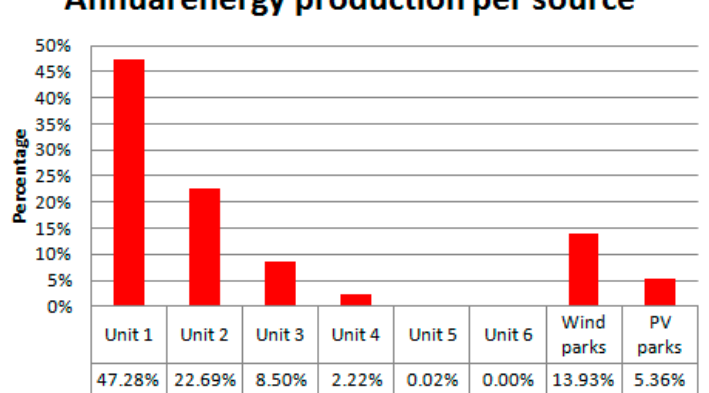
Figure 5. Annual energy production in Samos Island from different sources (no hybrid power station existence).